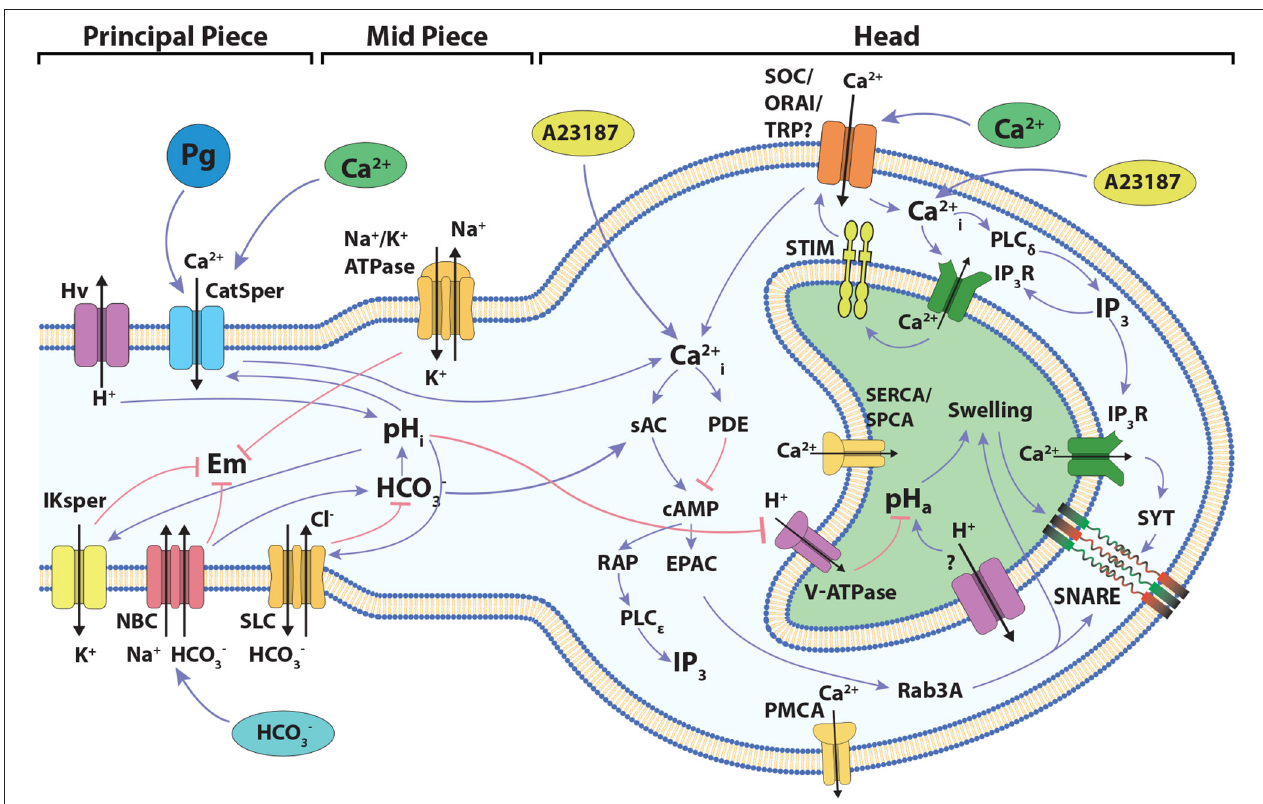
FIGURE 1 | Diagram of the signaling network involved in the development of acrosome reaction in human sperm. The cartoon shows the main components and signaling events to be considered in the development of the model described in the present work. Blue links connecting components indicate positive interactions, while red links indicate negative interactions. The localization of the different components among the head and the flagellum are indicated. Progesterone activates CatSper indirectly through a lipid hydrolase (Miller et al., 2016).